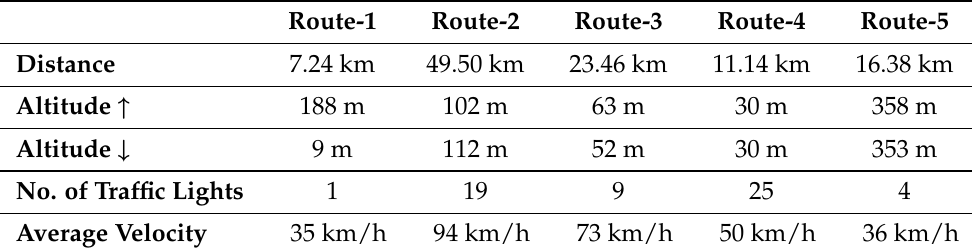
Table 1. Characteristics of the selected test